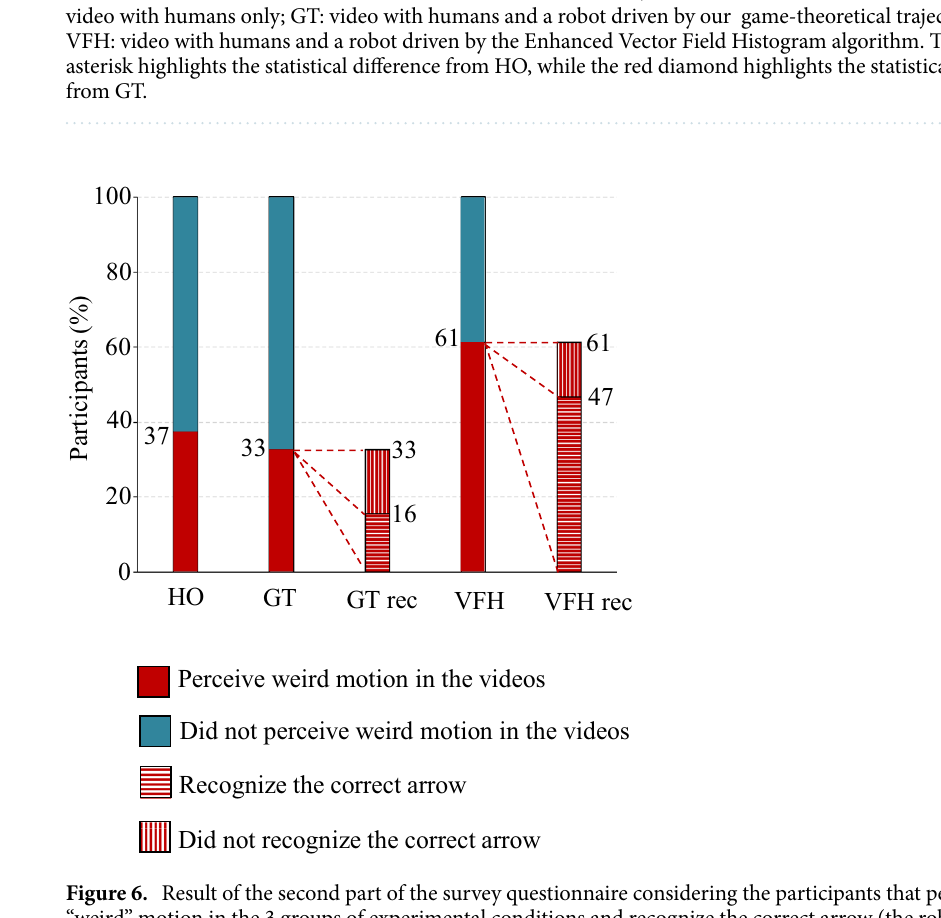
Figure 6. Result of the second part of the survey questionnaire considering the participants that perceive a “weird” motion in the 3 groups of experimental conditions and recognize the correct arrow (the robot) in the populated environment (GT rec. , VFH rec.). HO: video with humans only; GT: video with humans and a robot driven by our game-theoretical trajectory planner; VFH: video with humans and a robot driven by the Enhanced Vector Field Histogram